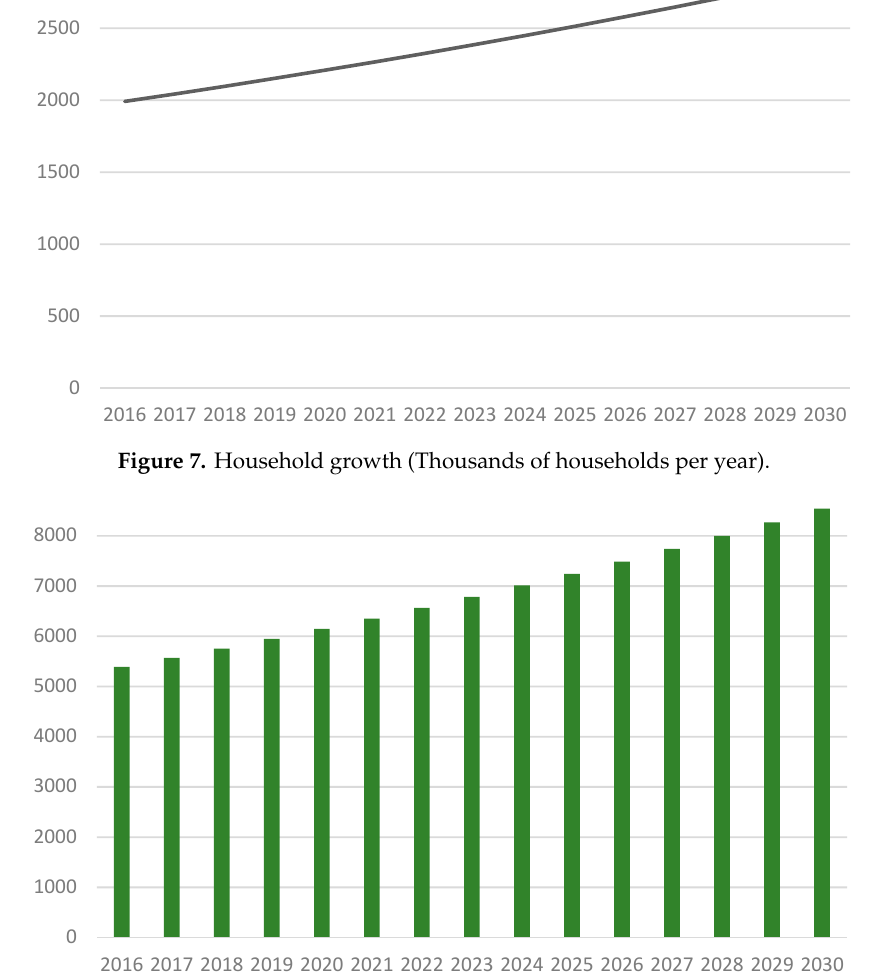
Figure 8. Total primary energy demanded under the BAU scenario (Thousands of Barrel of Oil Equivalent per year).